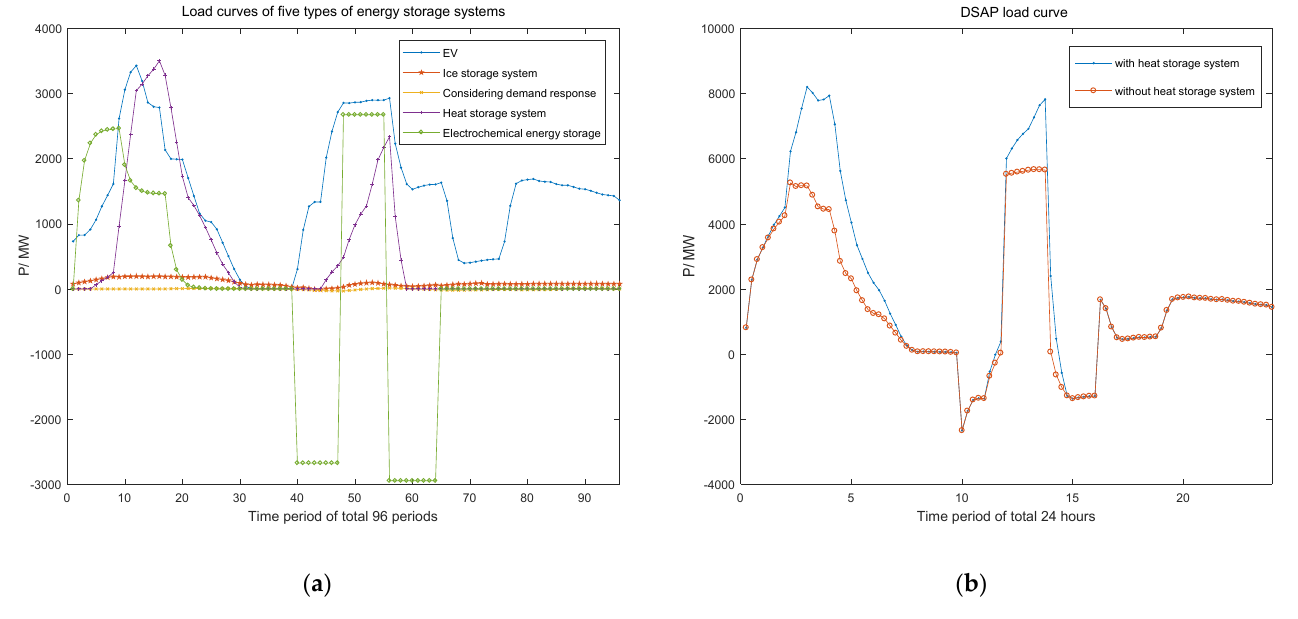
Figure 9. The load curve of distribution energy storage systems in 2025: ( a ) charging electric load curves of five types of energy storage systems; ( b ) DSAP total charging power load curve including EVs and ice storage, considering demand response and a decentralized shared system on a day using heat storage systems (in winter) and without the use of heat storage systems (in summer). Table 2. The electricity price of large industrial power in Guangzhou, China, in its distribution grid. Peak and Valley Time